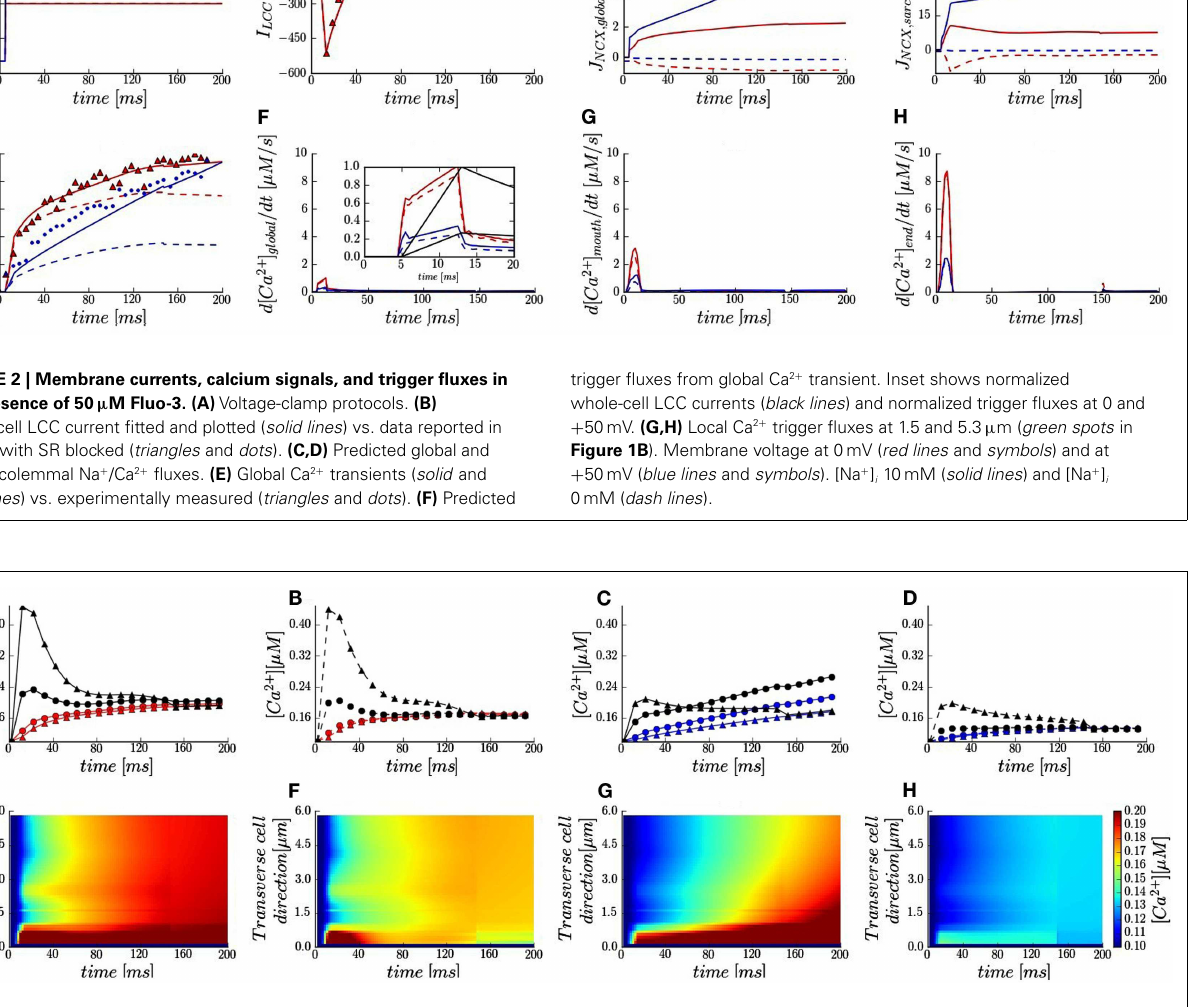
FIGURE 3 | Local calcium signals in the presence of 50 µ M Fluo-3. (A–D) Local Ca 2 + transients taken at two featured spots along the scanning line ( red and blue lines and symbols ) and the t-tubule membrane ( black lines and symbols ): circle − 1.5 µ m; triangles − 5.3 µ m. Membrane voltage at 0mV [ red